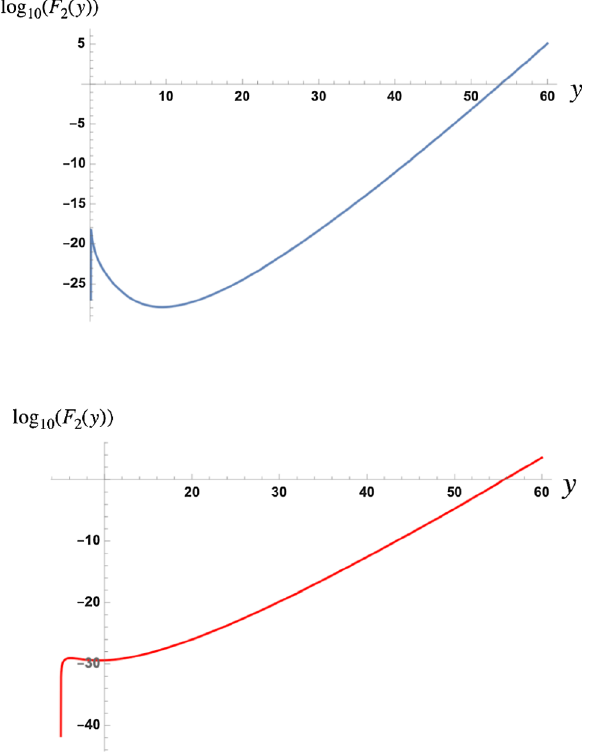
Fig. 2 Log of ratio of the calculated number density of X -particles to the equilibrium number density (4.5) calculated in the limit n X (cid:11) n eq ; left panel: y in = 0 . 1 and right panel: y in = 5